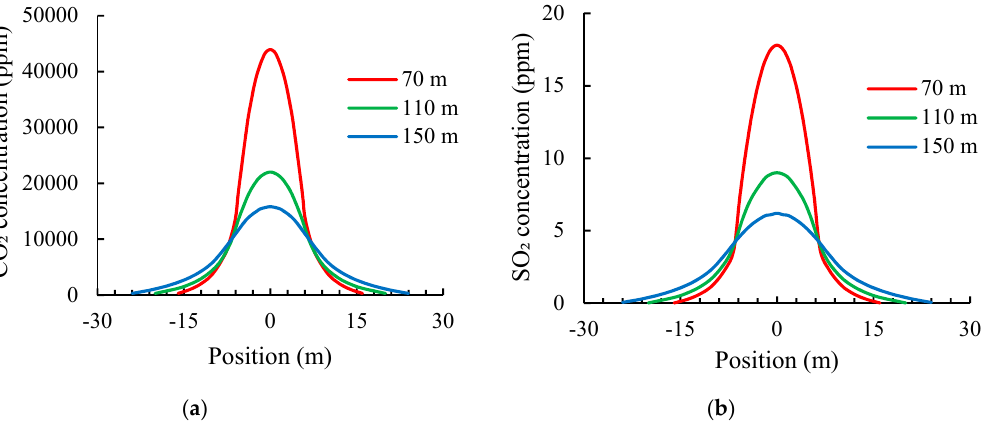
Figure 10. Concentration distributions of CO 2 and SO 2 in the cooling tower. ( a ) CO 2 ; ( b ) SO 2 .